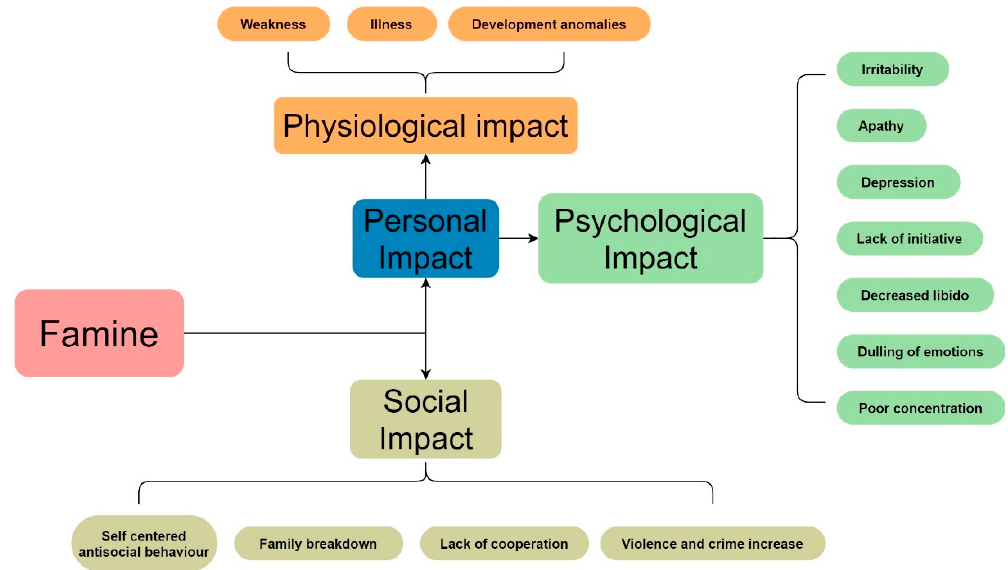
Figure 2. The impacts of Agro-Meteorological Famine (AMF) on individuals and society.